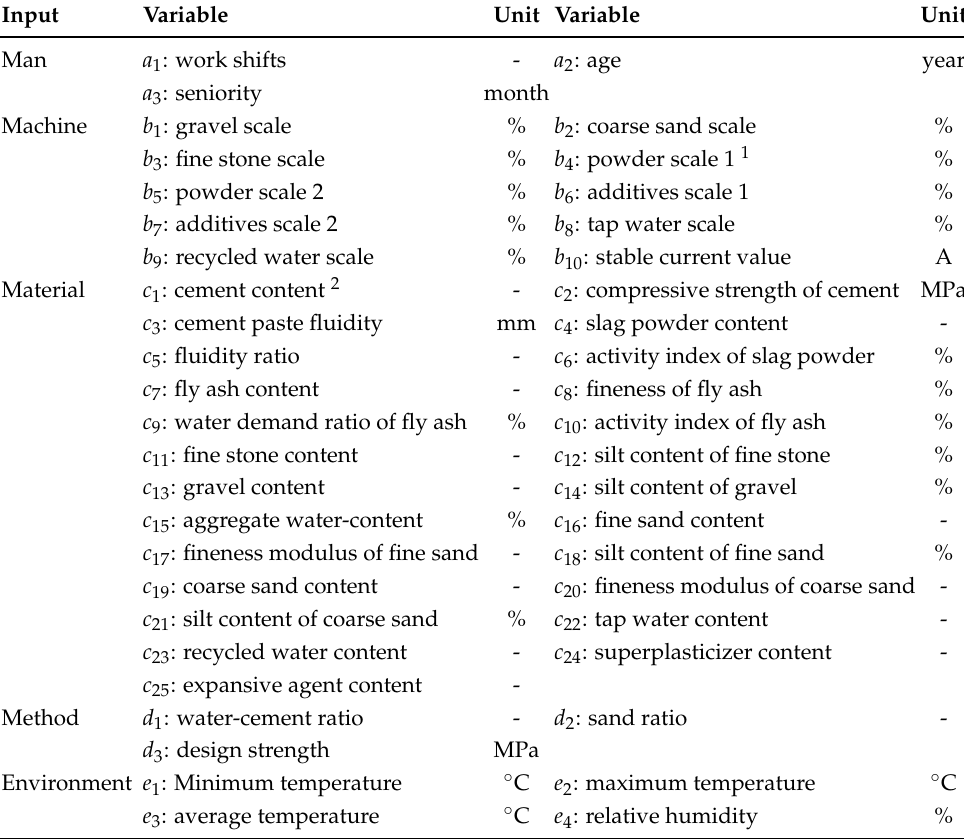
Table 1. Influential process factors for concrete production from five